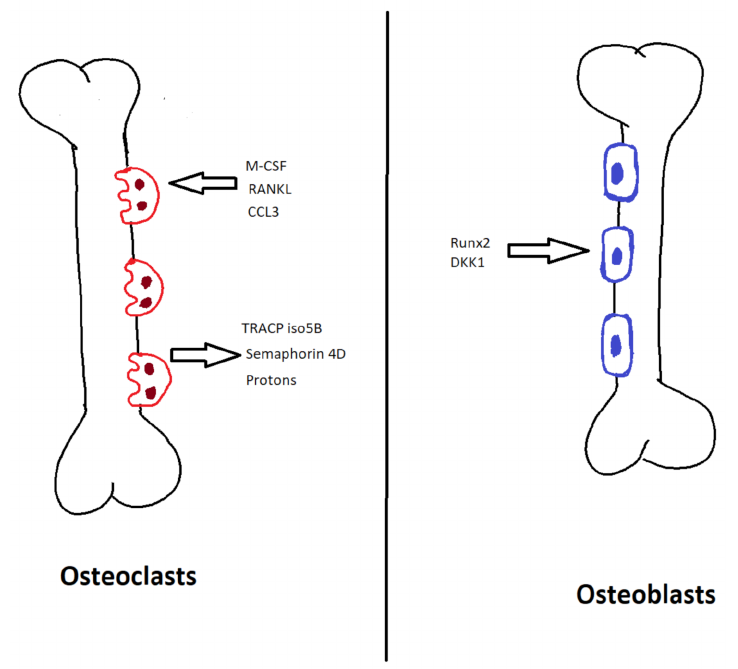
Figure 1. Normal bone remodeling. M-CSF, monocyte/macrophage colony stimulating factor; RANKL, receptor-activated nuclear factor-kappa B ligand; CCL3, C–C motif chemokine ligand 3; TRACP iso5B, tartrate-resistant acid phosphatase 5b; Runx2, runt-related transcription factor 2; DKK1, dickkopf WNT signaling pathway inhibitor